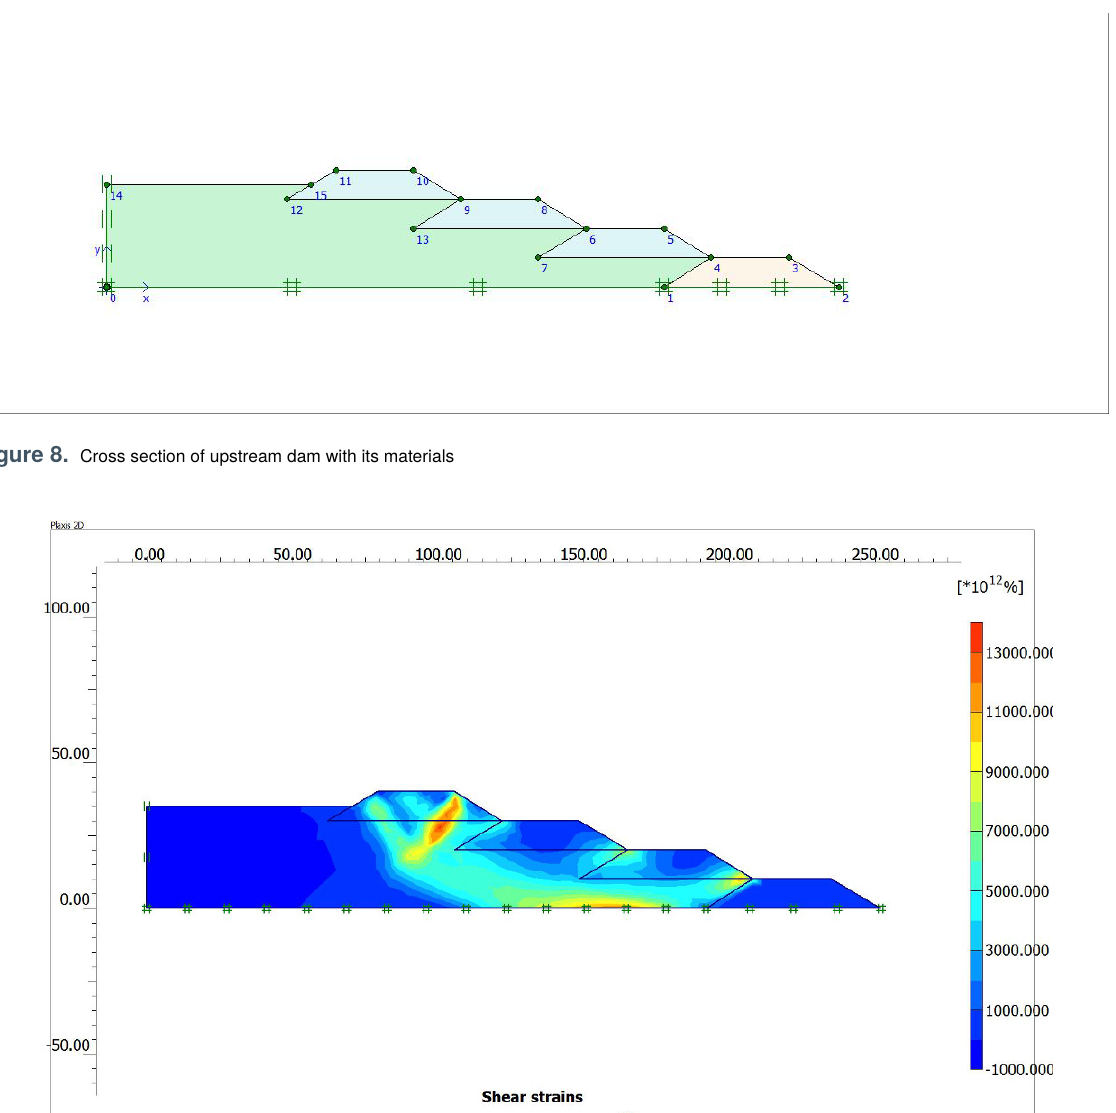
dam/embankment using red mud should be covered. An- other aspect also is that it should be checked for the hy- draulic fracturing of the dam/embankment, which is basi- cally to check the tension zone or cracked zone and the phreatic line. In the traditional limit equilibrium method it is not possible to find out the stress strain in the body of the embankment. Hence, in the present study tailing